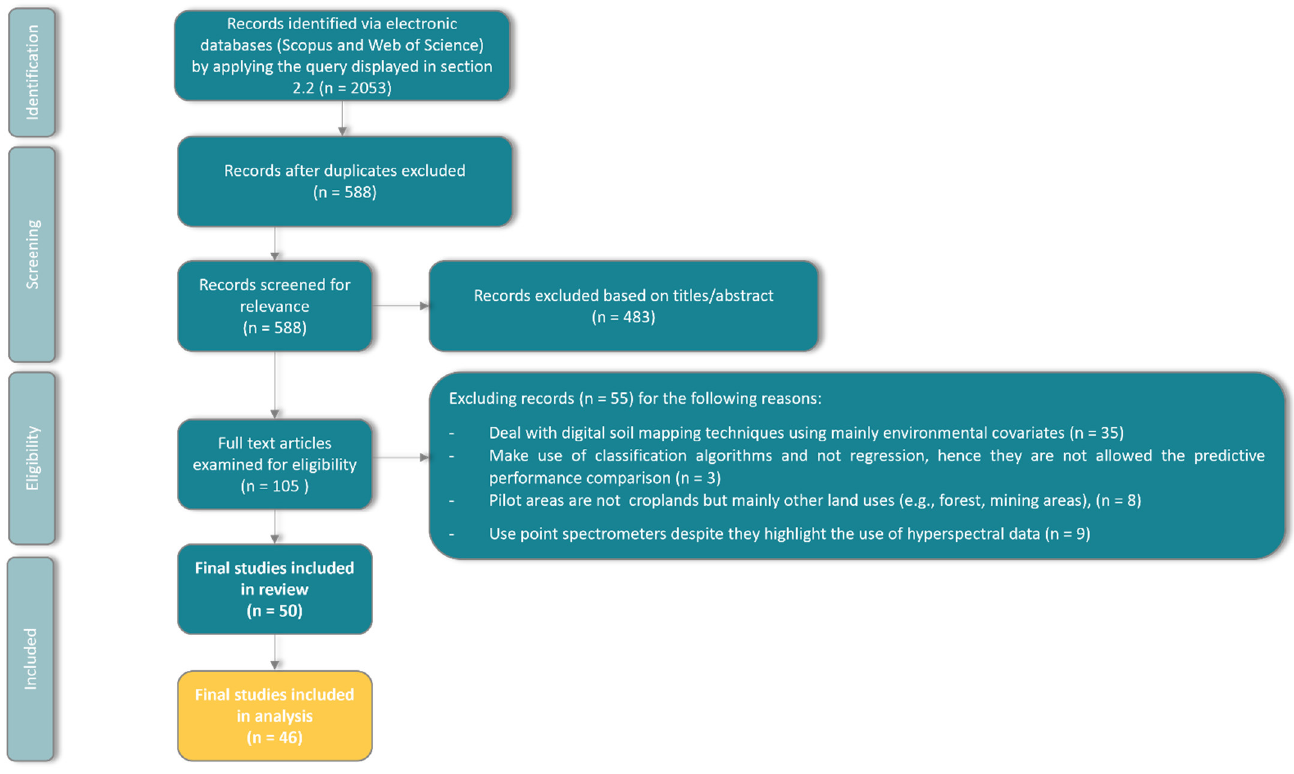
Figure A1. The preferred reporting items for systematic reviews and meta-analyses methodology flow diagram of the current review.